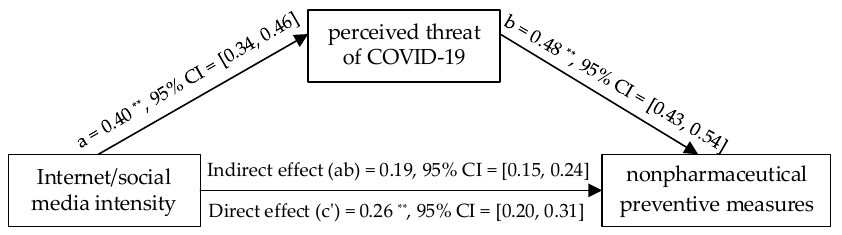
Figure 1. Results of the mediation model. Note: n = 1006. ** p < 0.01.